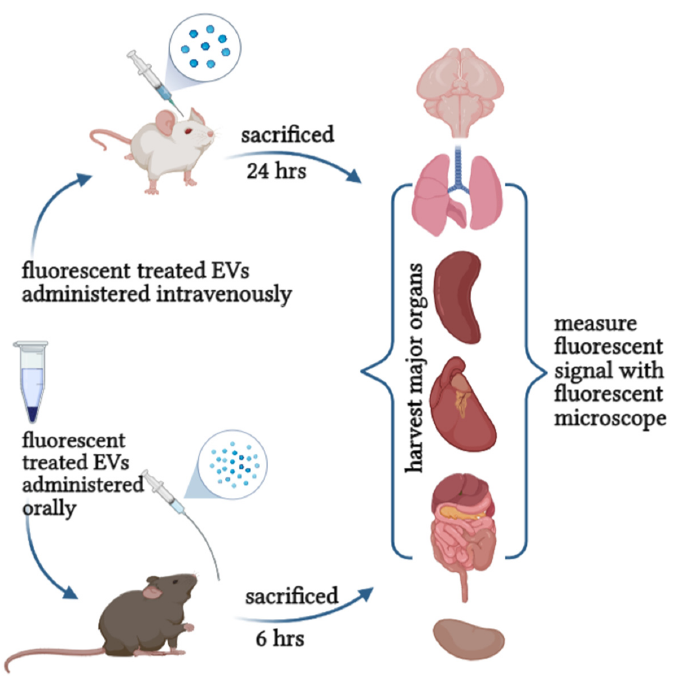
Figure 4. Evaluation the safety and toxicity of EVs can be achieved either orally or intravenously.